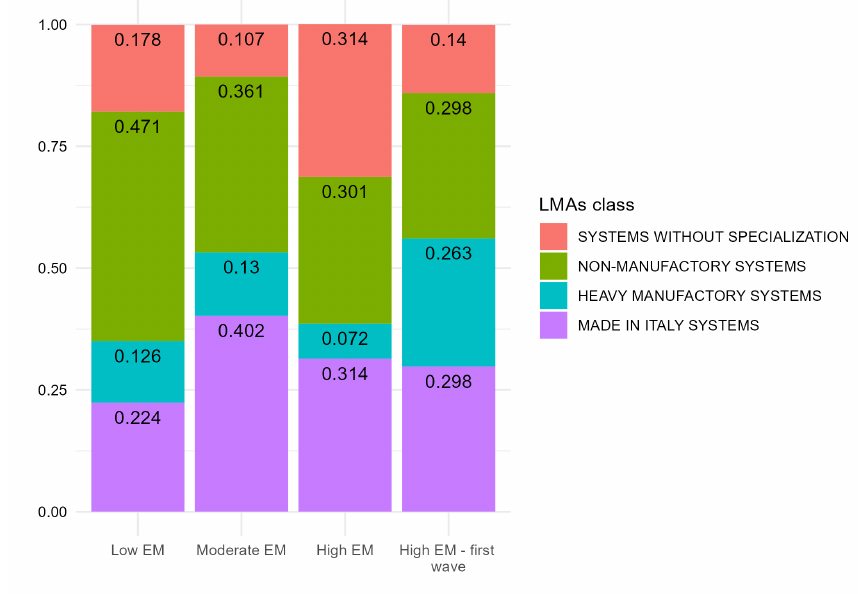
Figure A3. Percentage of LMA classes within the clusters.